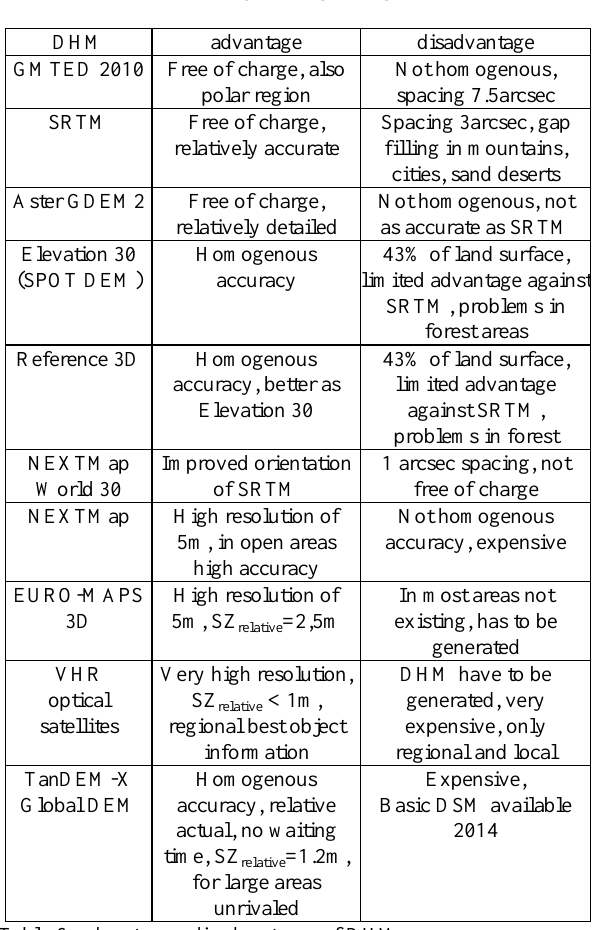
Table 6: advantages, disadvantages of